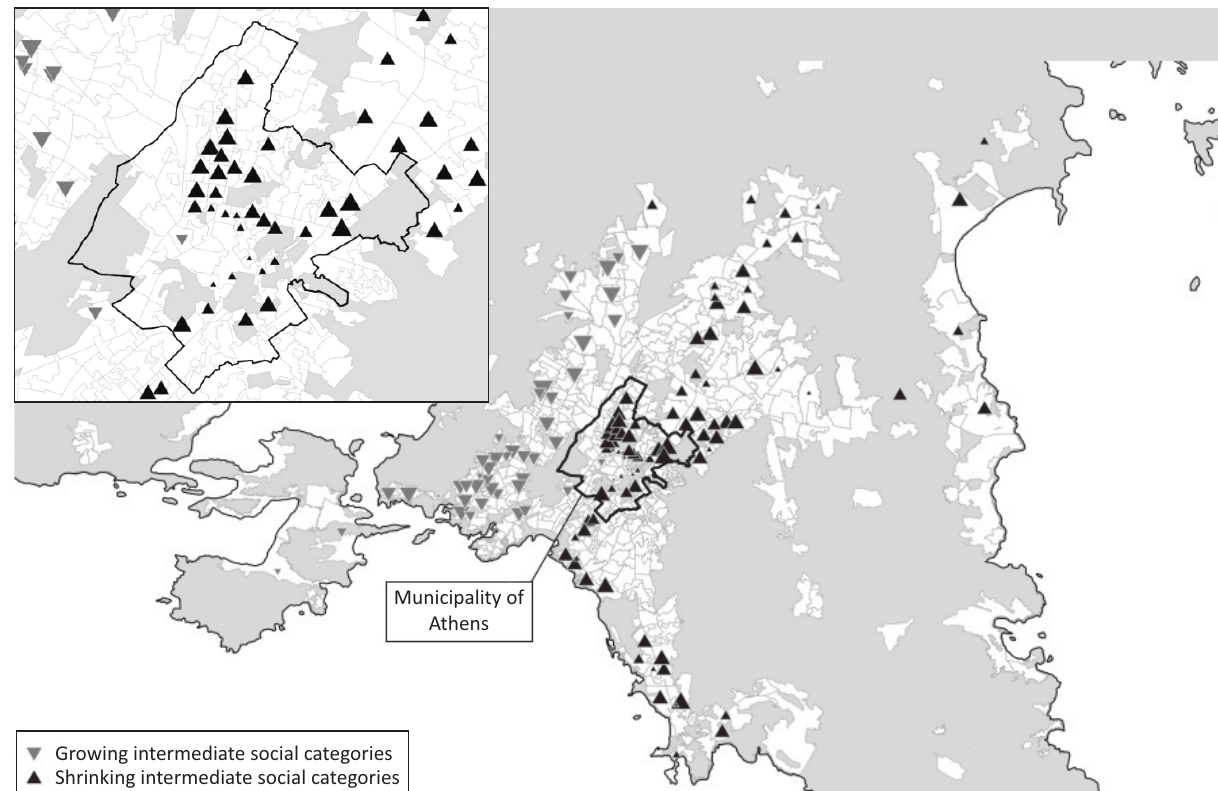
Figure 2. Residential spaces in Athens metropolitan area with a growing or shrinking share of intermediate social categories between 1991 and 2011. Notes: Black triangles depict areas where the share of intermediate occupations decreased at least by − 17.5pp, i.e., 1 standard deviation ( − 7.8pp) more than their average decrease in 1991–2011 ( − 9.7pp); grey trian- gles represent areas where the share of intermediate occupations increased; areas without symbols correspond to areas with a mild decrease of intermediate occupations (up to − 17.5pp). The size of the symbols is proportional to the resident population aged